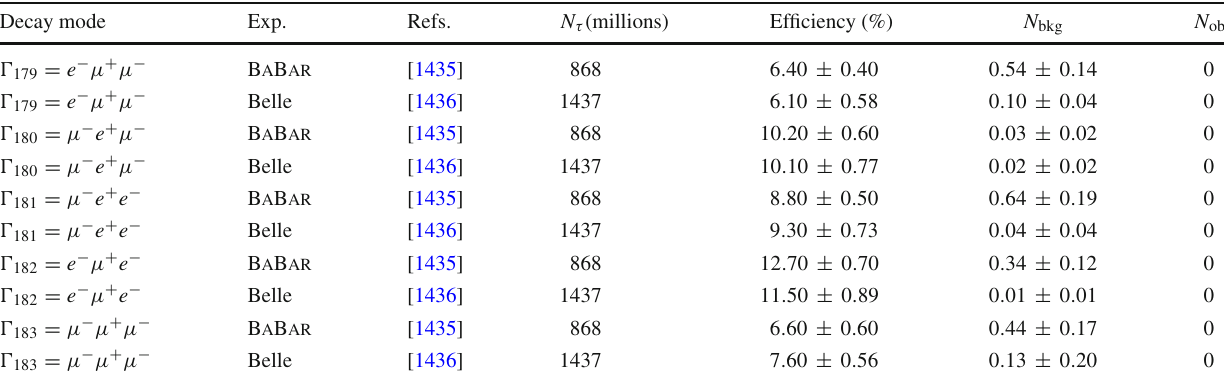
able. The measurement of sin 2 β ≡ sin 2 φ 1 from b → c ¯ cs transitions such as B 0 → J /ψ K 0